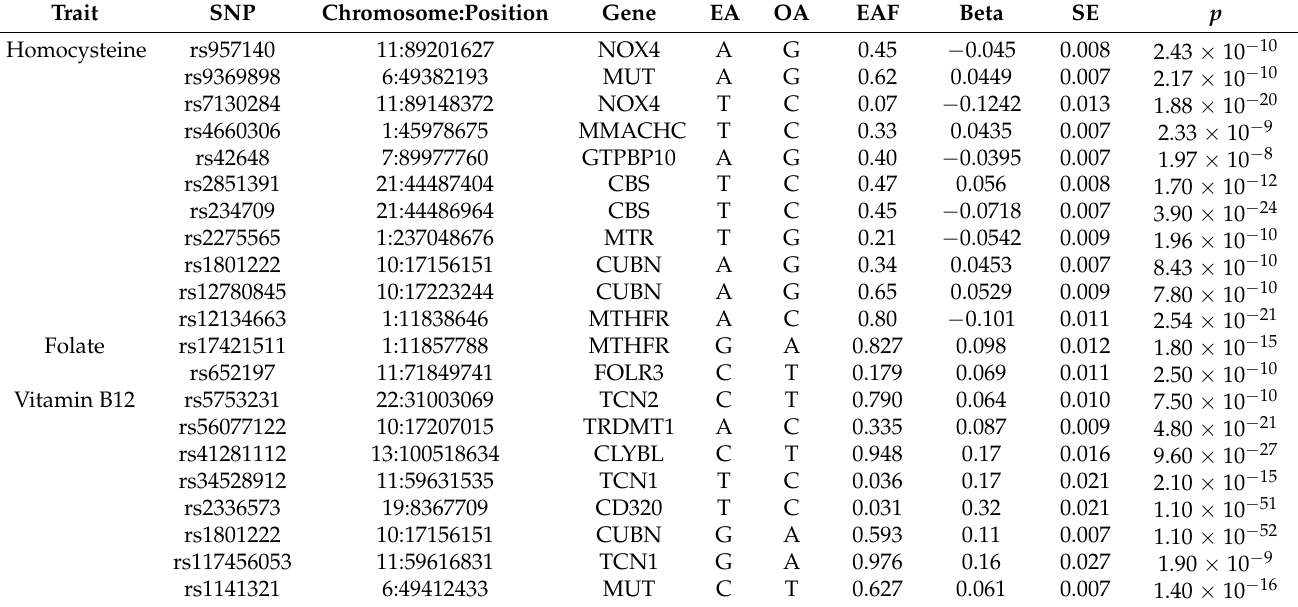
Table 1. Characteristics of SNPs for homocysteine, folate, and vitamin